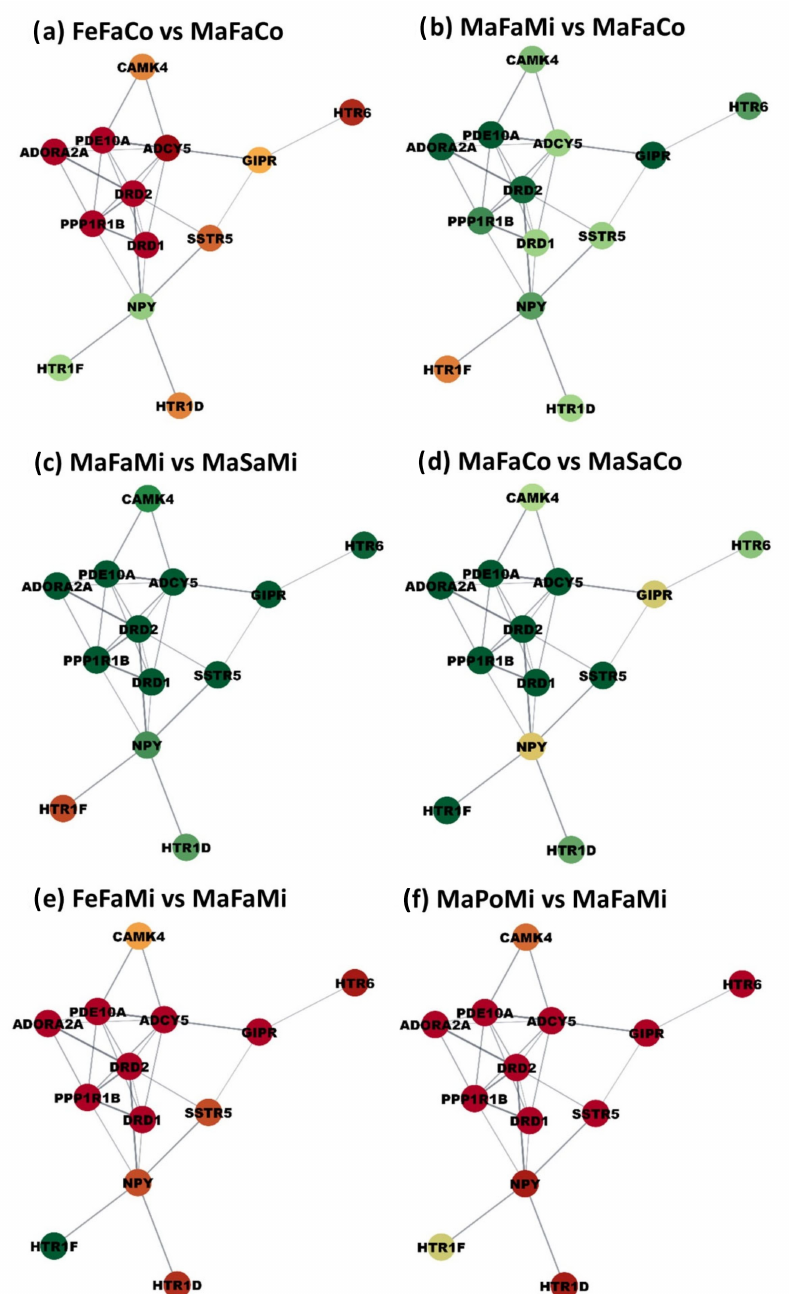
Figure 1. Gene networks for the cAMP signaling pathway showcasing prevalent, consistent, and extreme effects of maternal immune activation, postnatal stress, and sex across the genes. Nodes represent the genes; edges represent STRING database connections confirmed by the study; node color represents differential expression between groups. The first letters of the contrasts label denote the sex (Ma = male vs. Fe = female), followed by the postnatal stressor (Sa = saline vs. Po = Poly(I:C) vs. Fa = fasting), and the ending letters denote the maternal immune activation group (Co = non-MIA controls vs. Mi = MIA PRRSV-exposed animals). Colors range from red (under-expression in the first group vs. the second group) to yellow (neutral fold change value) to green (over-expressed in the first group vs. the second